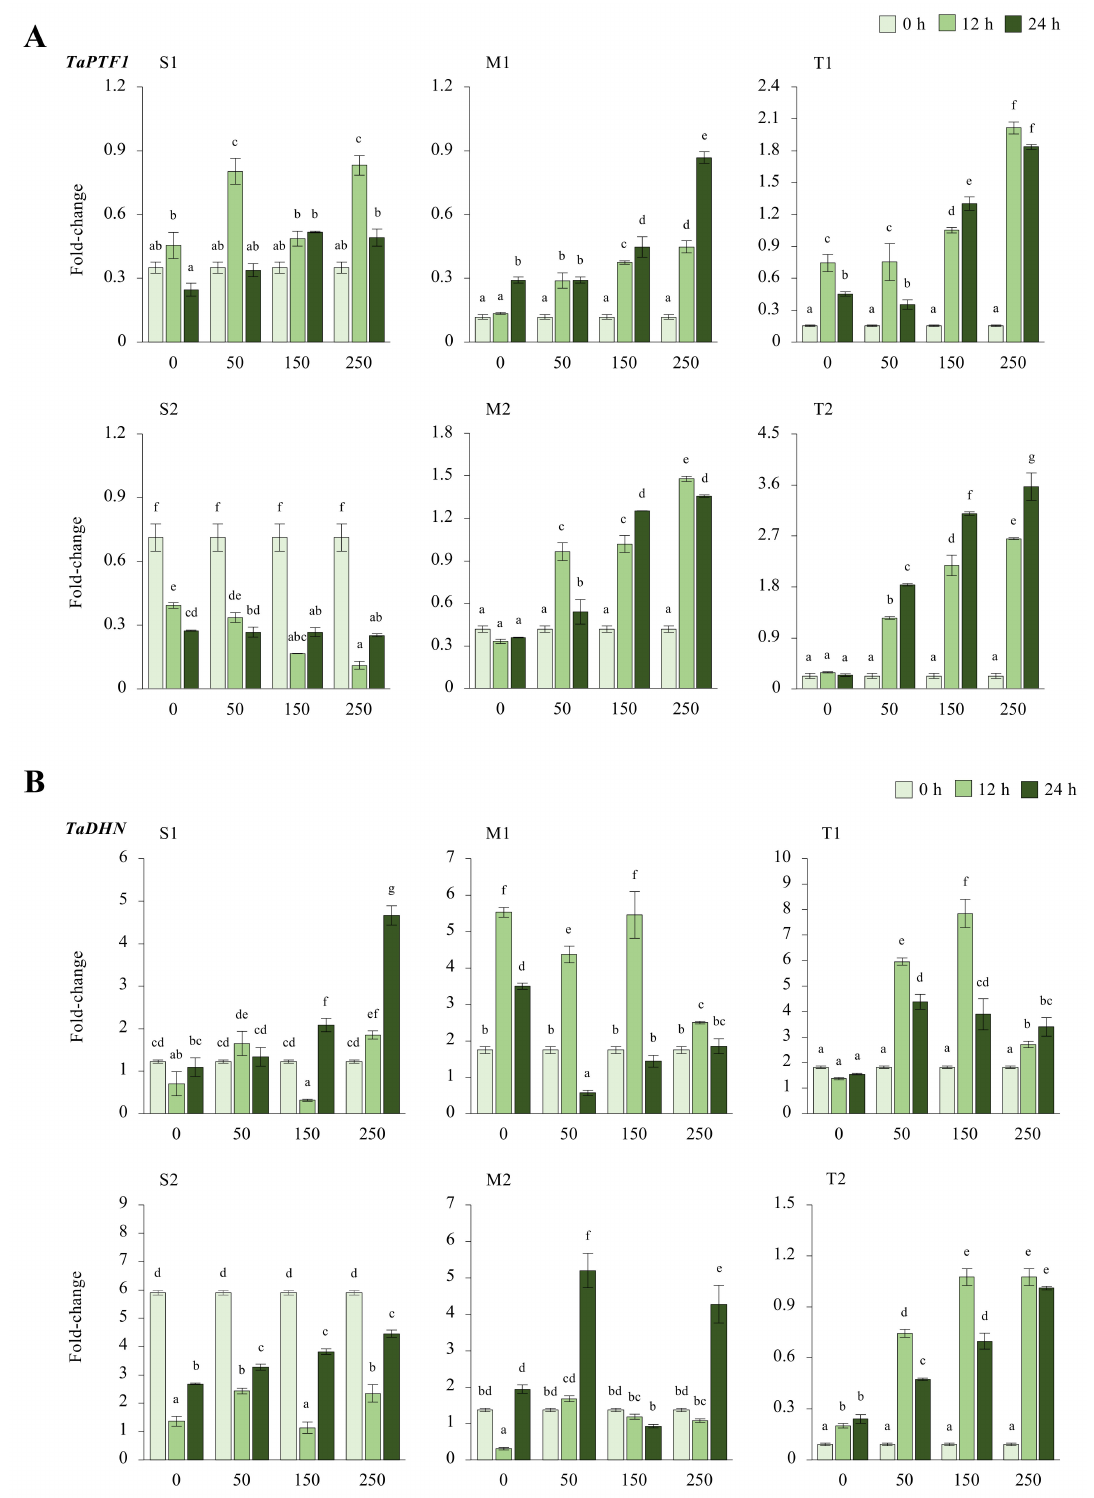
Figure A2. ( A ) The gene expression of the TaPTF1 and ( B ) TaDHN in the leaves of salt-sensitive (S1), S2, moderate (M1), M2, -tolerant (T1), and T2 genotypes exposed to 0, 50, 150, and 250 mM NaCl stress for 0, 12, 14 h. The Cq values formed the basis of qRT-PCR. The reference gene TaACTIN was used to standardize the Cq value for each sample. Means ( ± standard deviation) within the same graph followed by letters are significantly different at p < 0.05 according to the Tukey HSD test from independent biological triplicates ( n =